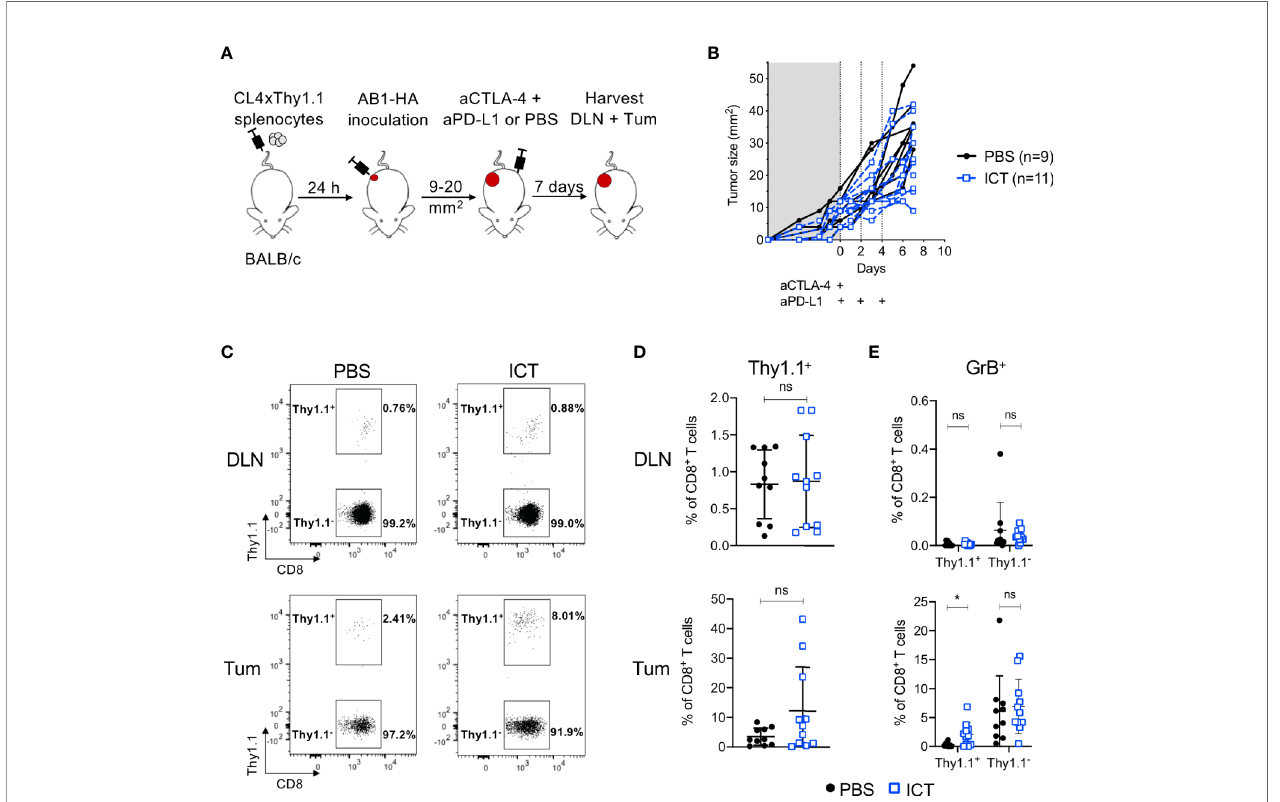
FIGURE 1 | ICT increases tumor in fi ltrating cytotoxic tumor antigen-speci fi c CD8 + T cells. (A) Experimental timeline. CL4xThy1.1 splenocytes were adoptively transferred into BALB/c mice one day prior to AB1-HA tumor inoculation. Mice were treated with ICT (aCTLA-4 and aPD-L1) or PBS when tumors reached 9 to 20 mm 2 in size. Tumors (Tum) and corresponding draining lymph nodes (DLN) were harvested 7 days post-treatment. (B) Tumor growth curves of mice treated with PBS (black) or ICT (blue). Each line represents an individual animal. Dotted lines indicate days of treatment. (C) Representative FACS plots, and (D) dot plots representing frequencies of CD8 + Thy1.1 + (HA-speci fi c) T cells in DLN and Tum of both treatment groups. (E) Frequency of granzyme B (GrB) expressing CD8 + Thy1.1 + or Thy1.1 − T cells. Data in dot plots represented as mean ± SD. Mann-Whitney U tests were used to compare groups; *P ≤ 0.05. Data represents two independent